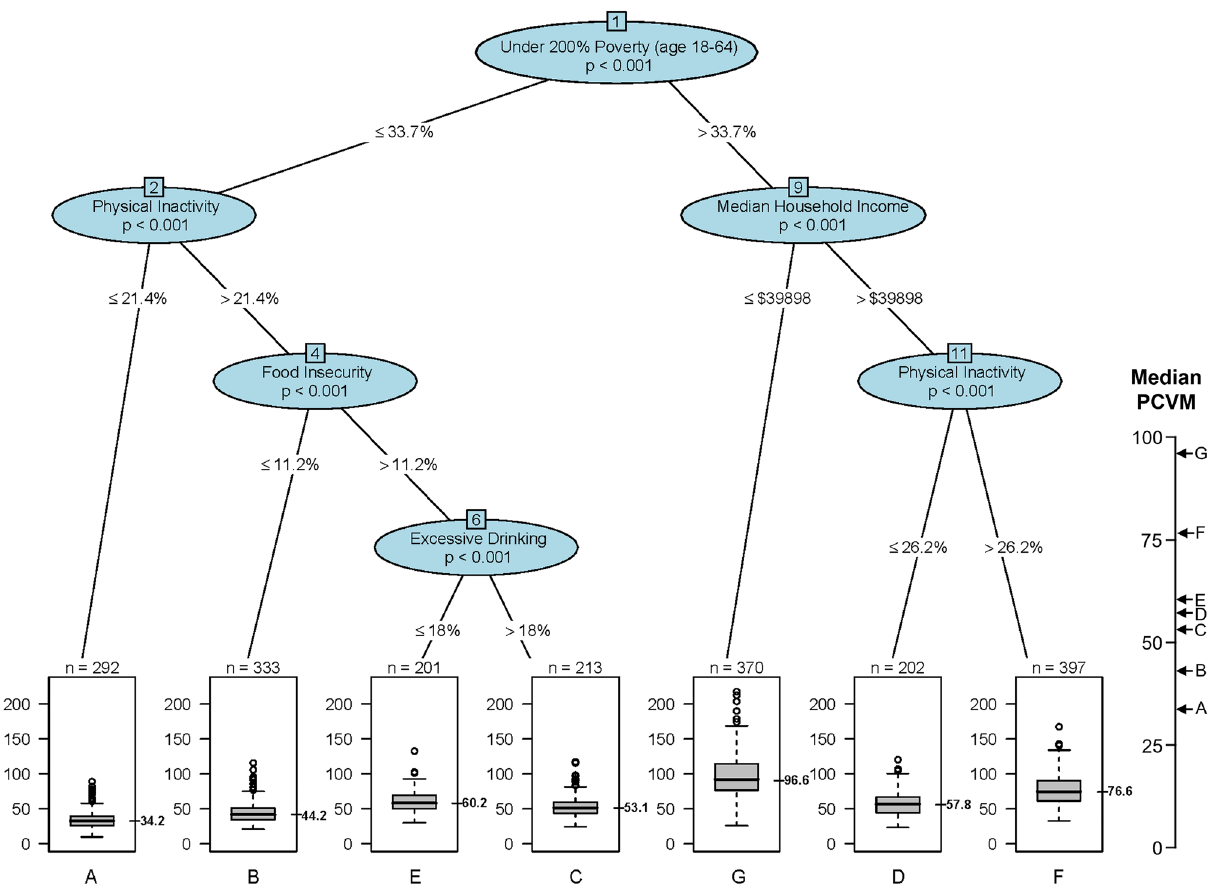
Figure 1. Classification and regression tree analysis (200 minimum counties at a terminal node) to predict county-level premature cardiovascular mortality (PCVM) using counties in the training set (N = 2008). Notes: Each path down to a terminal node represents a county phenotype. Box plots in the terminal nodes represent age-adjusted PCVM (per 100,000